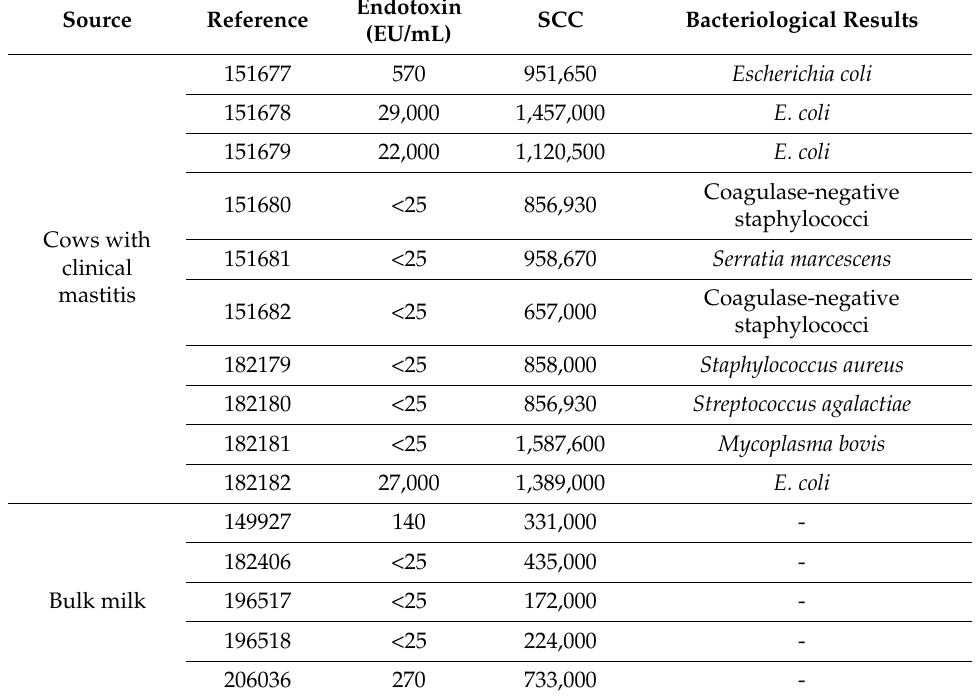
Table 4. Endotoxin levels (EU/mL), somatic cell counts (SCC) and microbiological results in cow milk samples from different